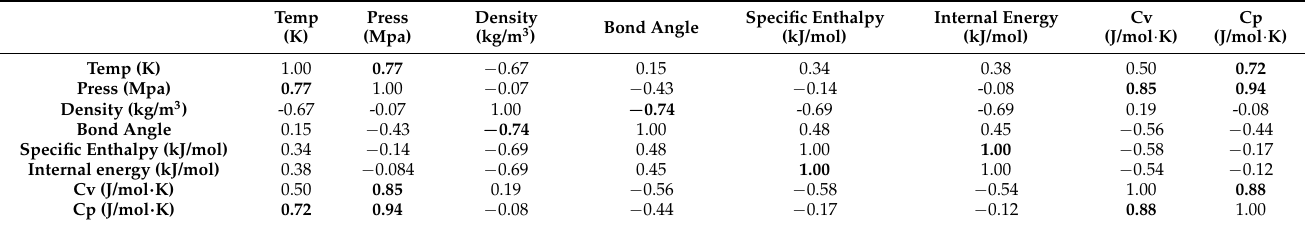
Table 2. Correlation matrix. Highlighted values are >|0.7|. The correlation matrix, carried out on the data of Table 1, highlights that the variation of the geometry of the molecule, the angle, is mainly due to the density.